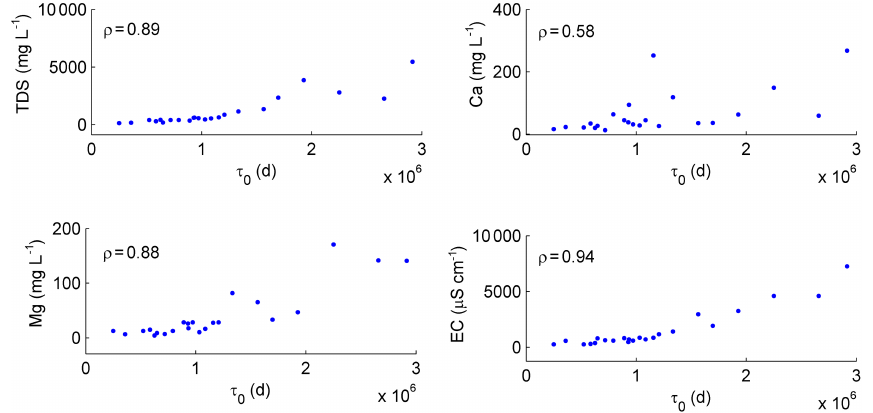
Figure 7. Relation between simulated subsurface mean transit time ( τ 0 ) of each discharge wetland and the concentration of various chemical constituents in the wetland. Here, the pathlines discharged into each wetland and their associated transit times were calculated by back tracking from 100 uniformly distributed particle release points located at each discharge wetland. ρ refers to the correlation coefficient between τ 0 chemical concentrations.